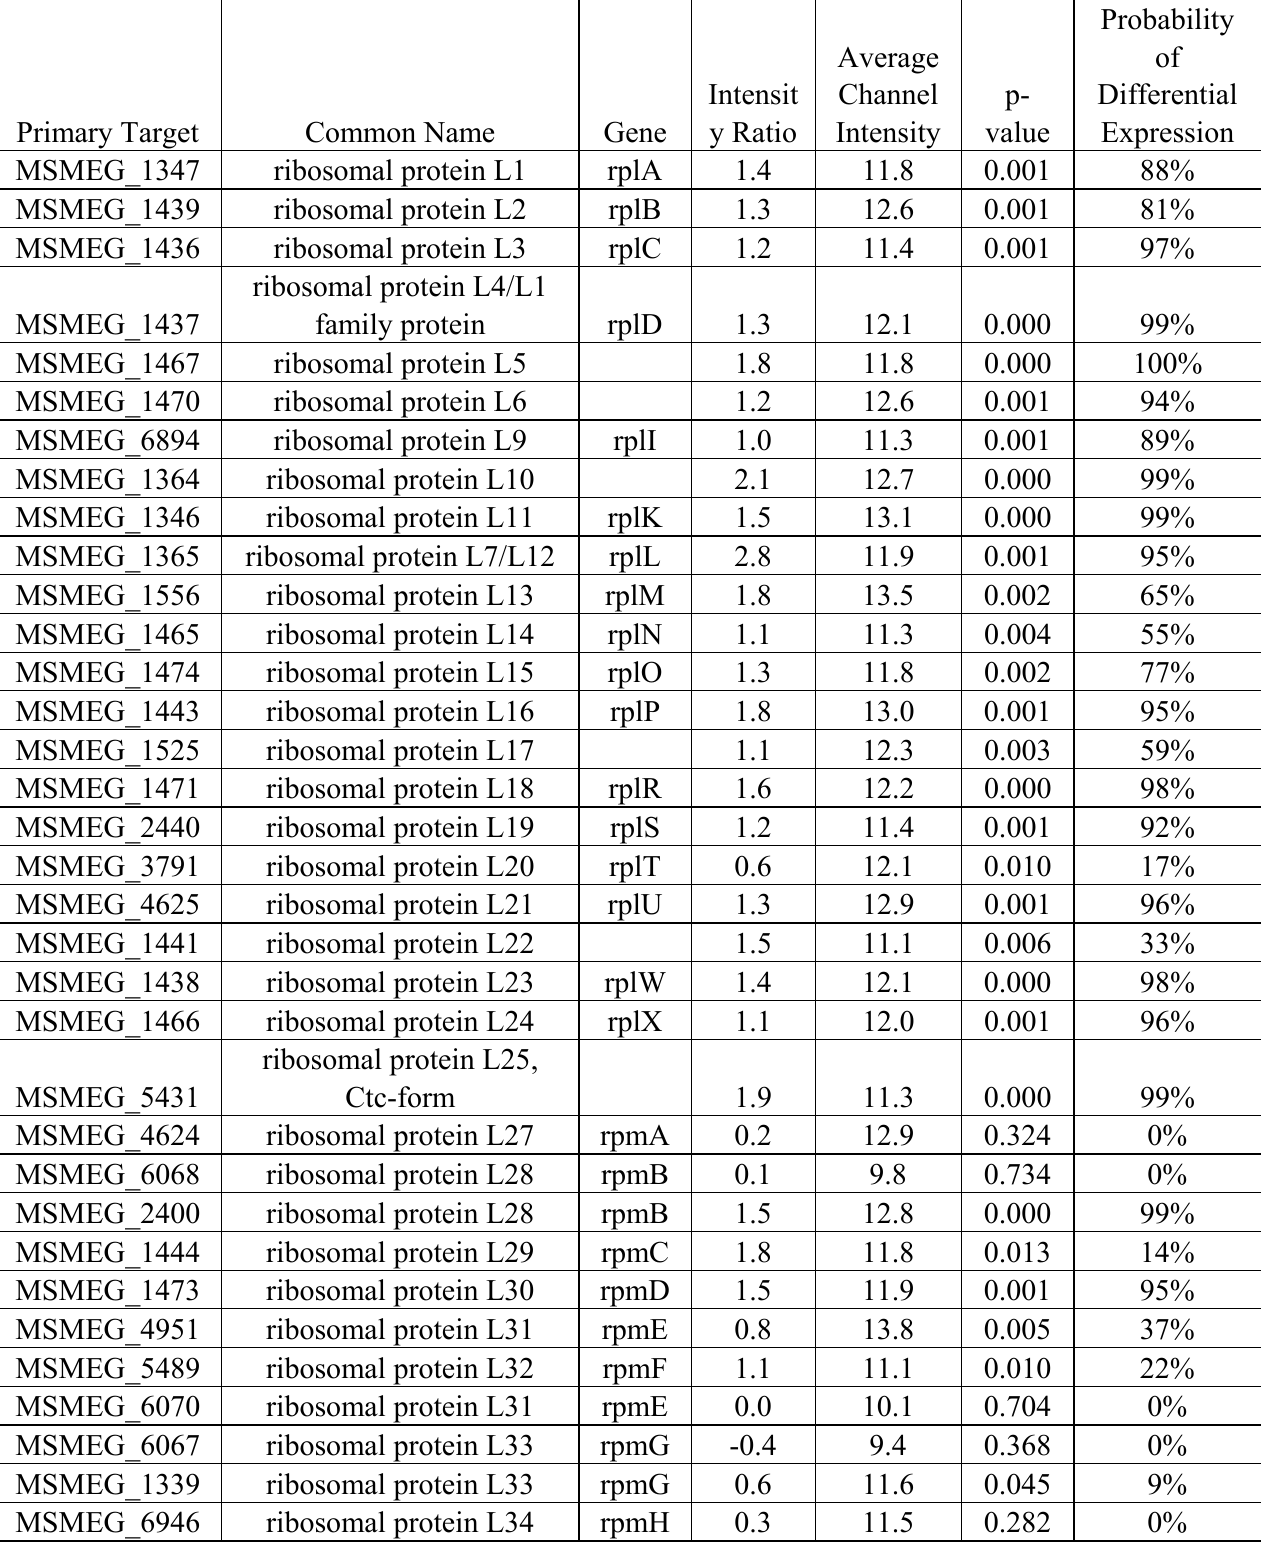
Appendix Table 1. Ribosomal genes up-regulated in log phase (non-spray dried log versus stationary